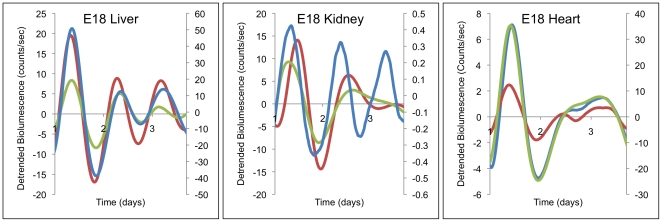
Circadian rhythms expressed by embryonic heart, kidney and liver in- vitro.
Per2::luc embryonic heart, kidney and liver placed in culture show circadian oscillations in light emission with average periods of 24.36, 25.39 and 22.25. The first day of recording is not shown due to transient activity. Data were detrended as described in methods. Tissues from the same embryo are indicated by the same color line.